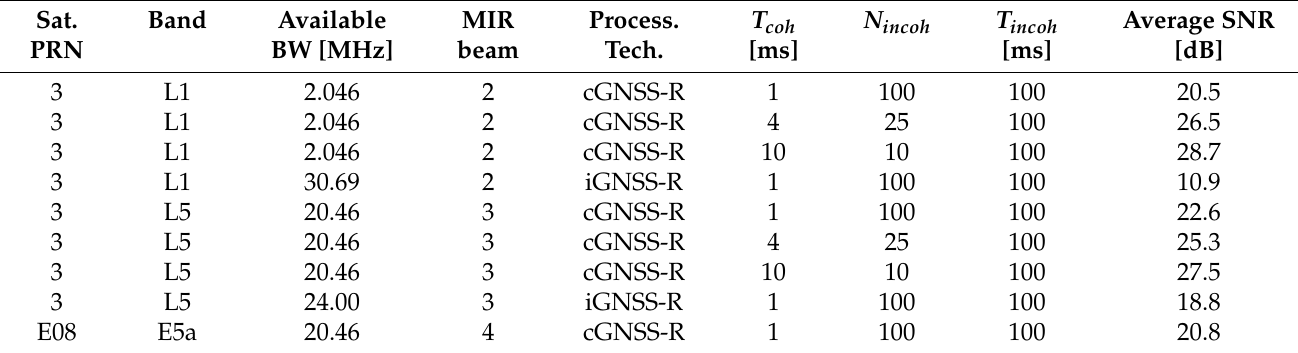
Table 1. Summary of the MIR data processed in this work. Available bandwidth (BW) refers to the bandwidth limited by the public codes in cGNSS-R cases or by the total transmitted bandwidth in the iGNSS-R cases [10]. MIR has a measured average bandwidth at − 10 dB of ≈ 20 MHz at L1/E1, and ≈ 34 MHz at L5/E5a. Sat.